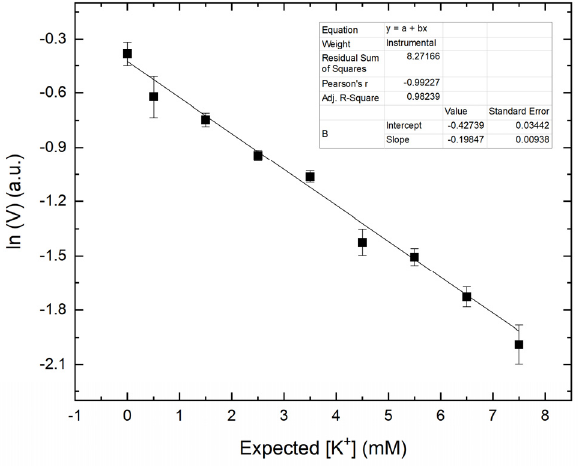
Figure 5. The ln of mean value component, V, for the treated blood plasma samples at given [K +